Question: What form of chart is displayed?
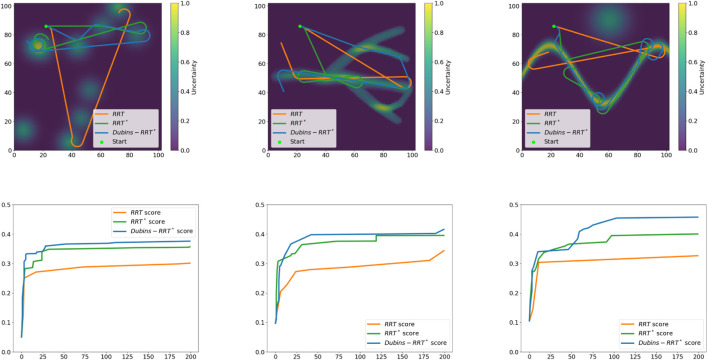
Answer: line